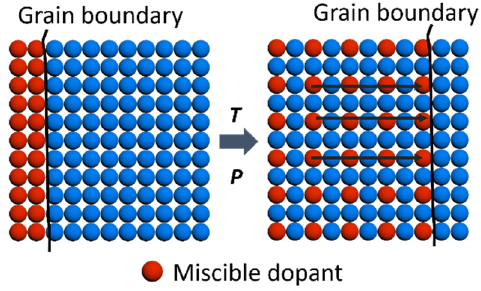
Figure 5. A schematic of diffusion-induced grain boundary migration.